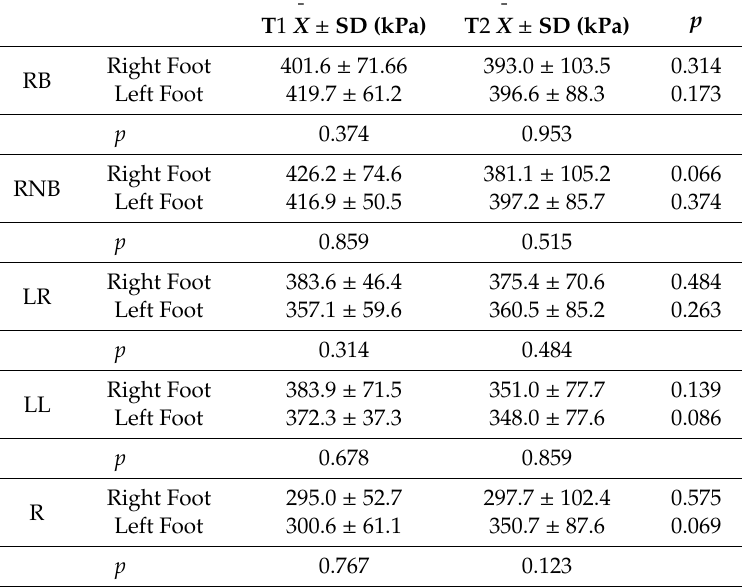
Figure 3. ( A ) Athlete with regular pattern; ( B ) athlete with flat pattern. Table 3. mPP—( X ) and standard deviation (SD). Comparison between the two season moments (T1, T2) and, in each season, between